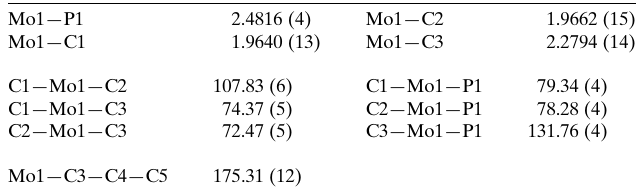
Table 4 Hydrogen-bond geometry (A˚ , (cid:4) ) for ( 1 ).